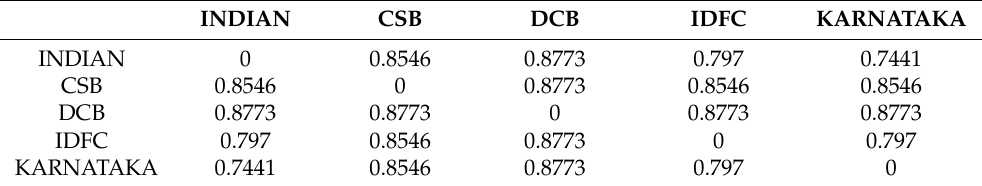
Similarly, we get the last component of the strength of connectedness in the form of an adjacency matrix using Algorithm 2 (see Table 17). Table 17. Adjacency matrix of the strength of connectedness (last component): reduced list of 5